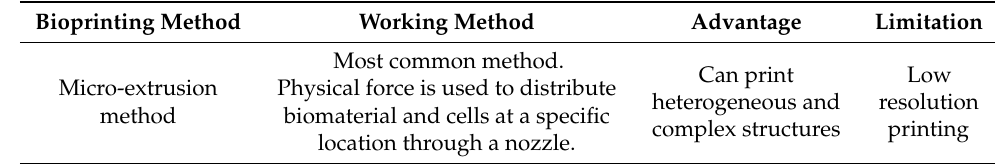
Table 3. Types of bioprinting methods and their